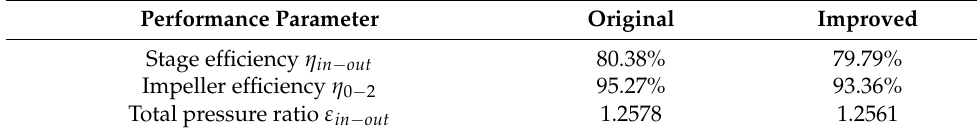
Table 6. Performance comparison of the compressor stages with different inlet